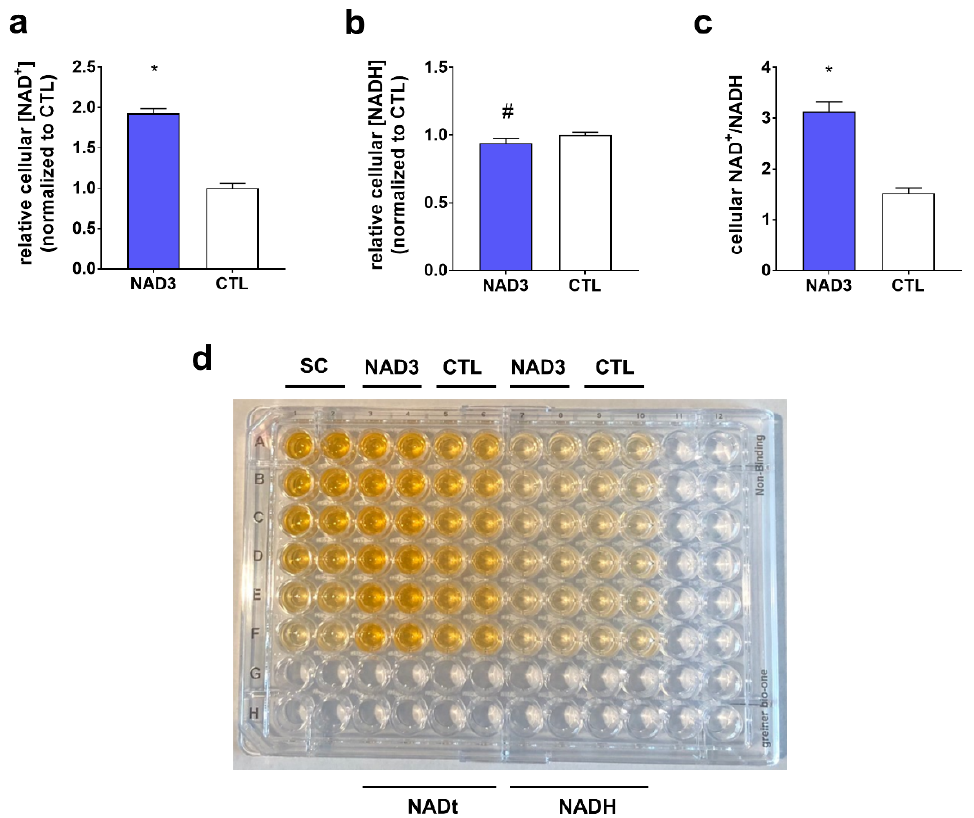
Figure 4. Effect of 24 h NAD3 treatments on cellular NAD + , NADH, and NAD + /NADH. Legend: these data illustrate that 24 h NAD3 treatments increased cellular NAD + levels (panel a ), decreased NADH levels (panel b ), and increased the NAD + /NADH ratio (panel c ). (Panel d ) illustrates a visual representation of assay results (SC indicates a standard curve, and NADt is NAD + + NADH where NAD + levels are determined by subtracting NADH levels from NADt levels). All data are presented as the means ± standard deviation values ( n = 6 treatment wells per condition), and significance was set at p < 0.05. Symbols: *, indicates more highly expressed in NAD3-treated versus control (CTL)-treated cells; #, indicates more highly expressed in CTL-treated versus NAD3-treated cells.